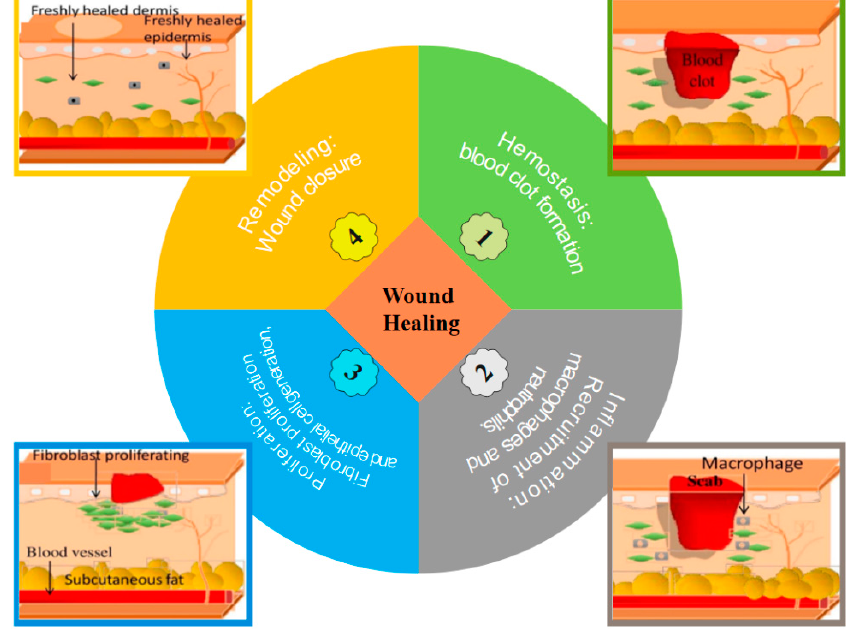
Figure 10. Schematic of the wound healing steps: ( 1 ) hemostasis, ( 2 ) inflammation, ( 3 ) proliferation, and ( 4 ) remodeling.